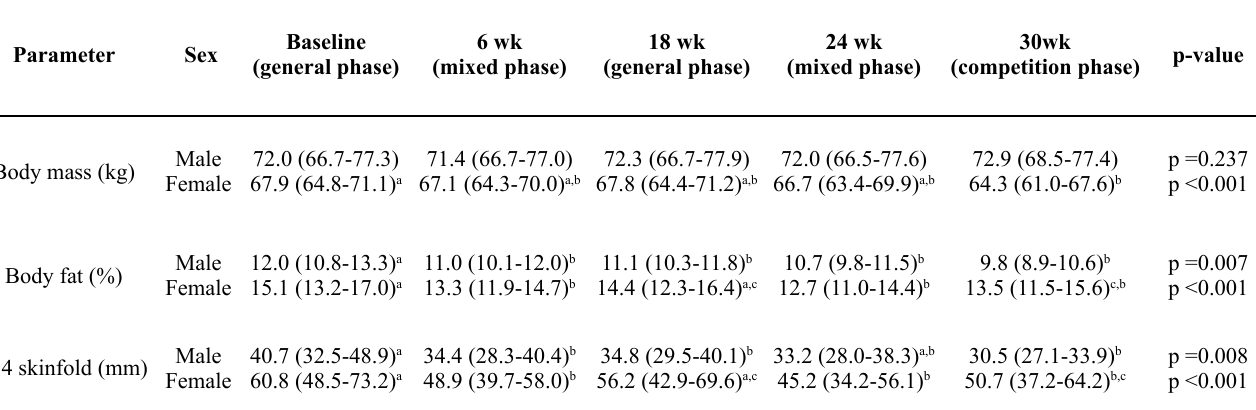
Table 1. Anthropometric data of male (n=10) and female (n=8) swimmers during a competitive season. Data presented as mean (confidence